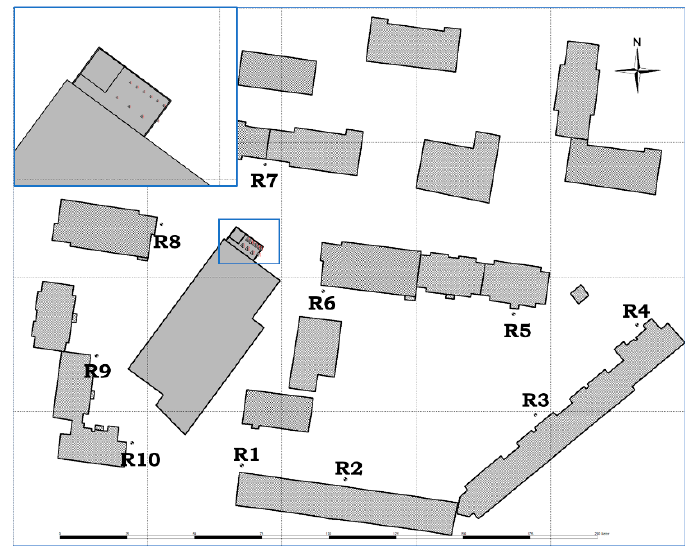
Figure 1. Thematic layers (shaded buildings: residential buildings, grey building: residential centre, loudspeakers: noise sources, points: virtual receivers).